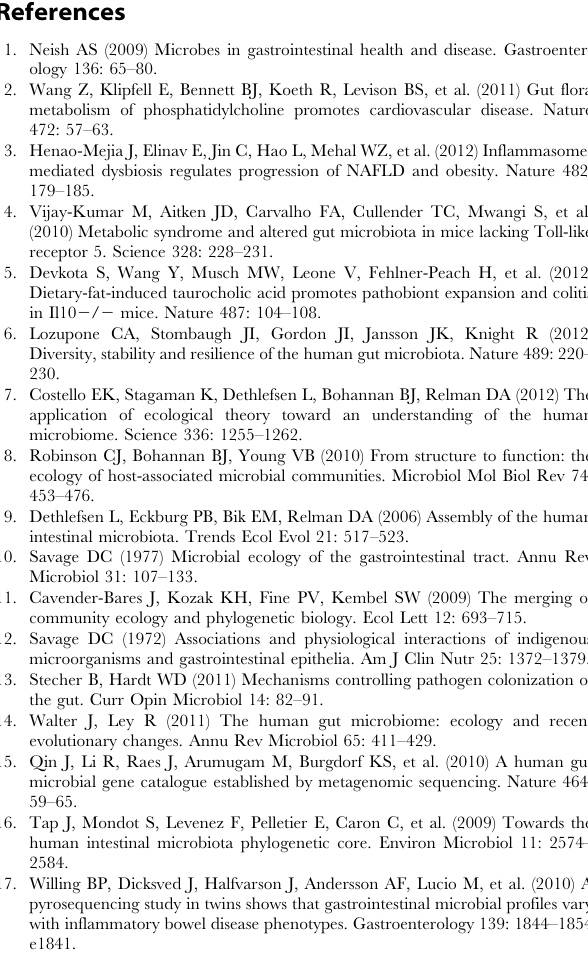
Figure S4 Temporal dynamics of core taxa within the Actinobacteria phylum. Abundances of the phylotypes iden- tified as persistent (present in . 80% of the samples) within subjects are presented in their phylogenetic context. A representative sequence of each OTU and the closest related type-strains were used to build trees with the neighbor-joining algorithm (1000 bootstrap replicates). Figure S5 Temporal dynamics of core taxa within the Bacteroidetes phylum. Abundances of the phylotypes identi- fied as persistent (present in . 80% of the samples) within subjects are presented in their phylogenetic context. Figure S6 Temporal dynamics of core taxa within the Firmicutes phylum (Clostridia cluster XIV). Abundances of the phylotypes identified as persistent (present in . 80% of the samples) within subjects are presented in their phylogenetic context. Figure S7 Temporal dynamics of core taxa within the Firmicutes phylum (Clostridia clusters non-XIV). Abun- dances of the phylotypes identified as persistent (present in . 80%